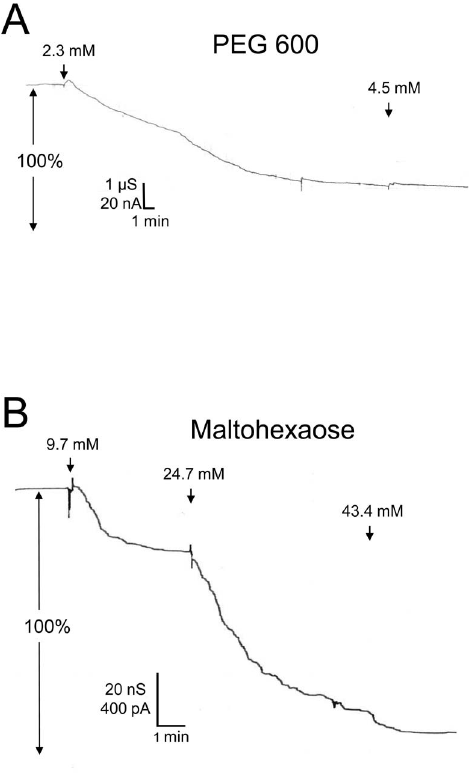
Figure 4. Titration of the P66-induced membrane conductance with PEG 600 (A) and maltohexaose (B). The membrane was formed with PC/ n -decane. The aqueous phase contained , 100 ng ml 2 1 P66, 1 M KCl and respective nonelectrolytes in the concentration as indicated; temperature=20 u C; applied voltage=20 mV.